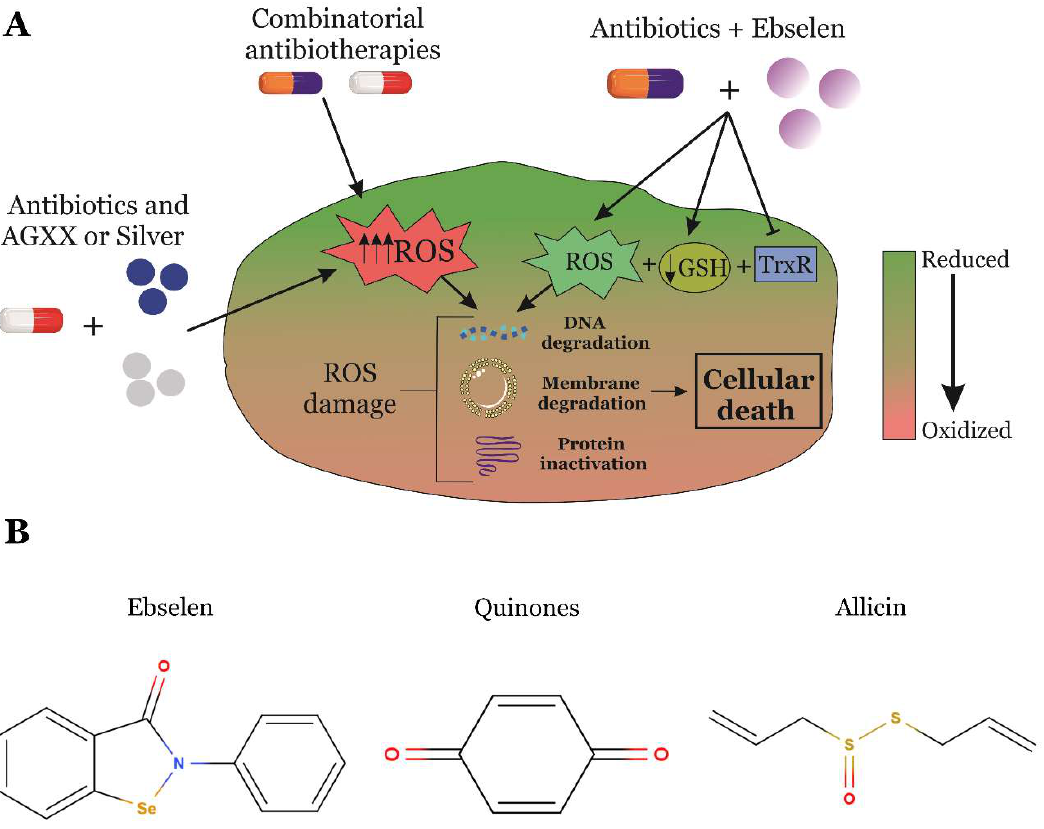
Figure 4. ( A ) Novel strategies based on the repositioning of antibiotics and the combination of di ff erent RONS-producing antibacterial compounds that may be used to treat infections caused by antibiotic-resistant strains. ( B ) Chemical structures of novel RONS-generating antimicrobials. On the other hand, the use of the antimicrobial coating AGXX ® (Largetec GmbH, Berlin) could be a promising RONS-inspired preventative strategy against antimicrobial resistant bacteria. AGXX ®